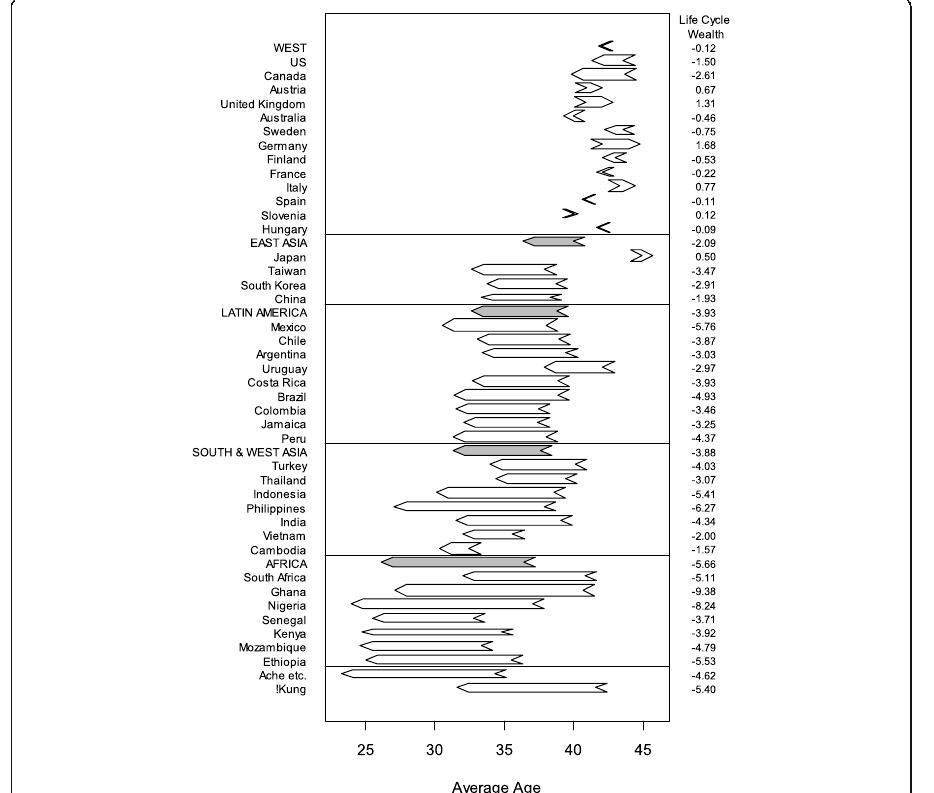
Fig. 4 The direction of income reallocation over the life cycle. Note: Head of arrows is average age of consumption, and tail is average age of production. Countries ranked within region by per capita GDP (ppp-adjusted, US$) in 2005. Regional averages are unweighted. Regions ranked by per capita GDP. Source: For Ache etc. and !Kung, see note to Fig. 1. For National Transfer Accounts data, see ntaccounts.org. Average age and per capita calculations use United Nations Population Division (2013) population data for year of NTA age